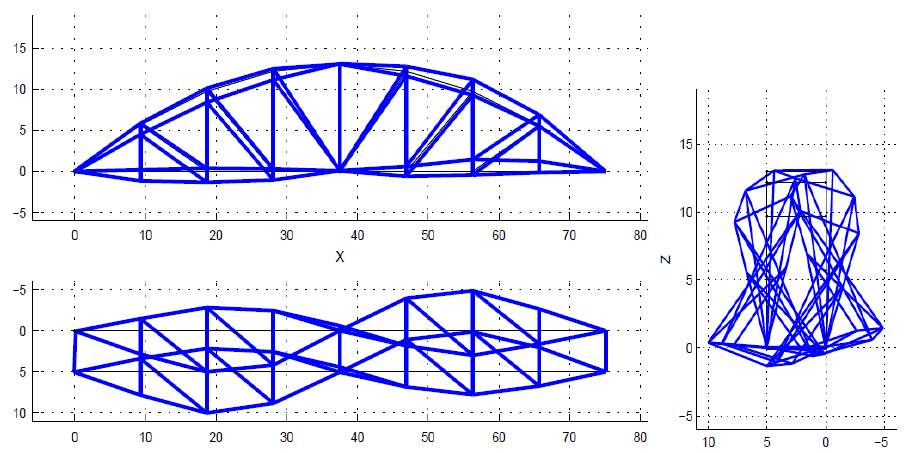
Figure 11. The identified mode 5, second torsion, f = 6.05 Hz, xi = 0.28%.